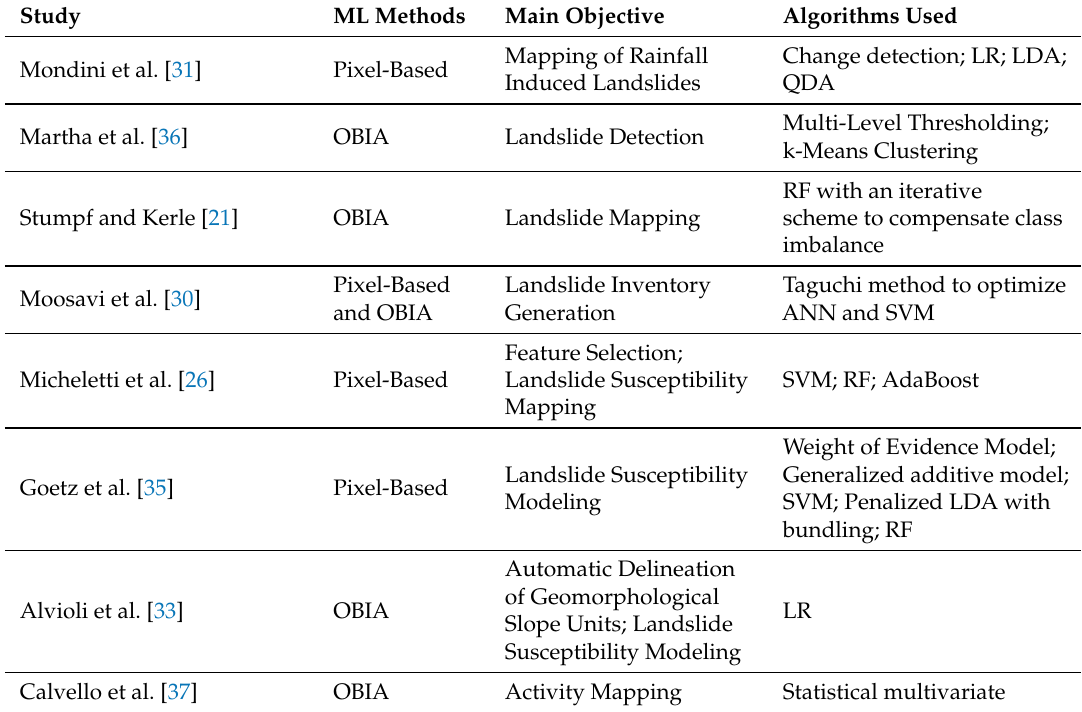
Table 2. Review of selected studies in automated mapping of landslides or landslide